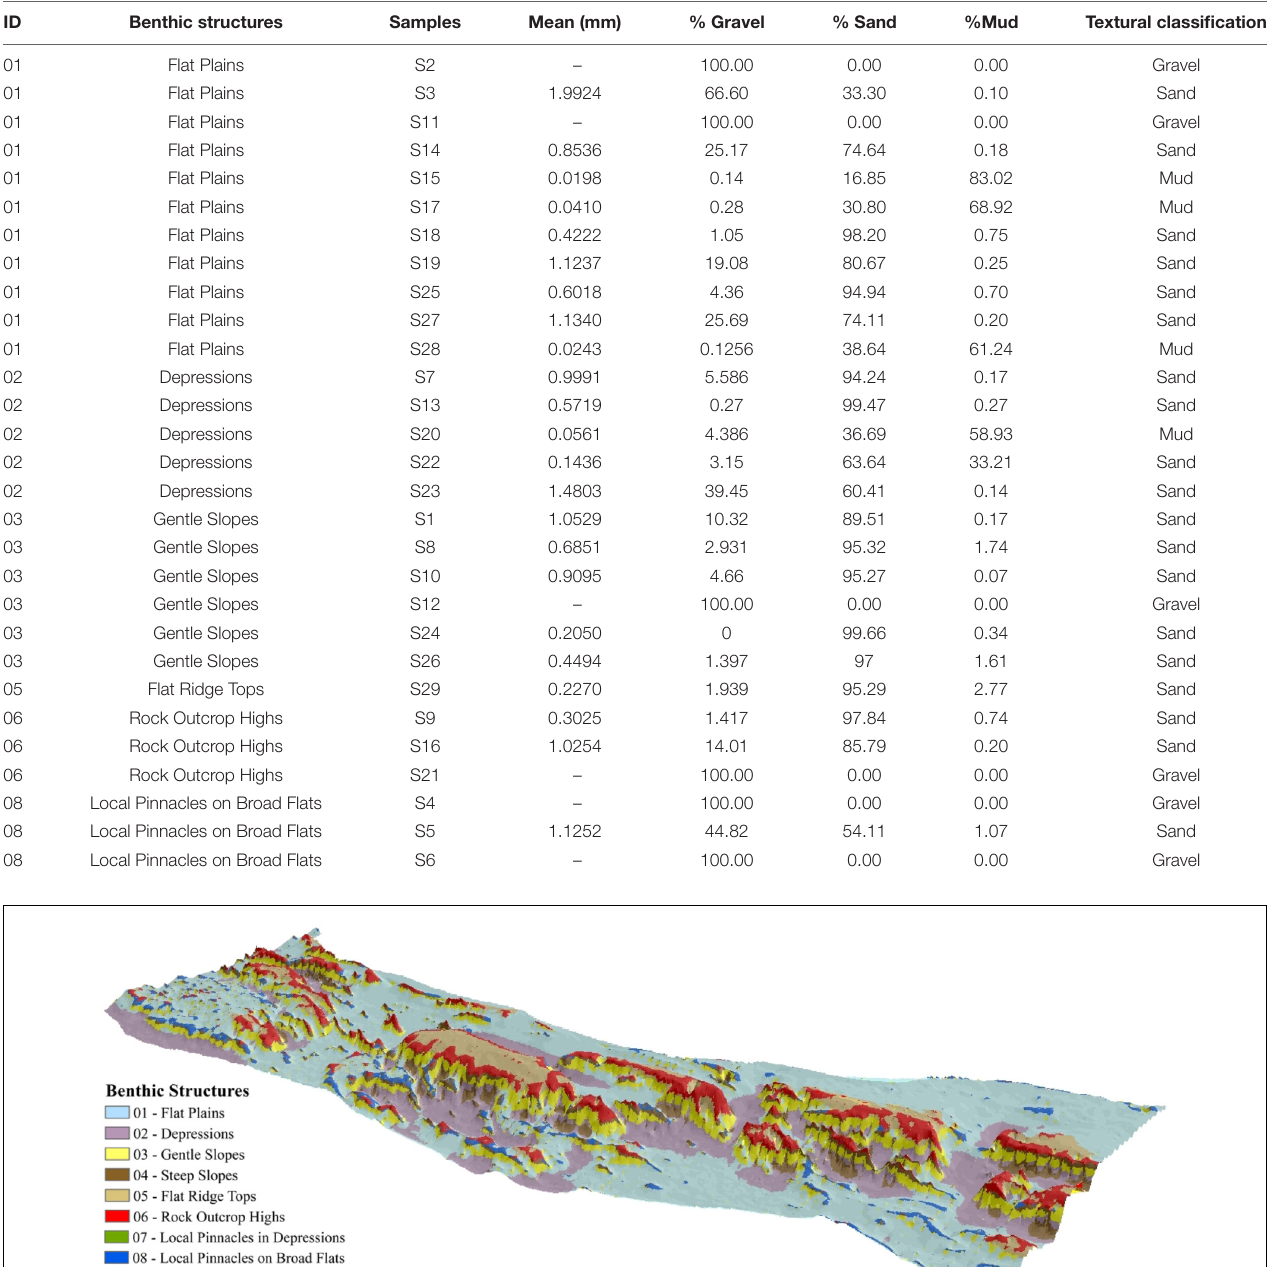
TABLE 3 | Mean grain size, percentages of gravel, sand, and mud of surface sediment. Benthic structures